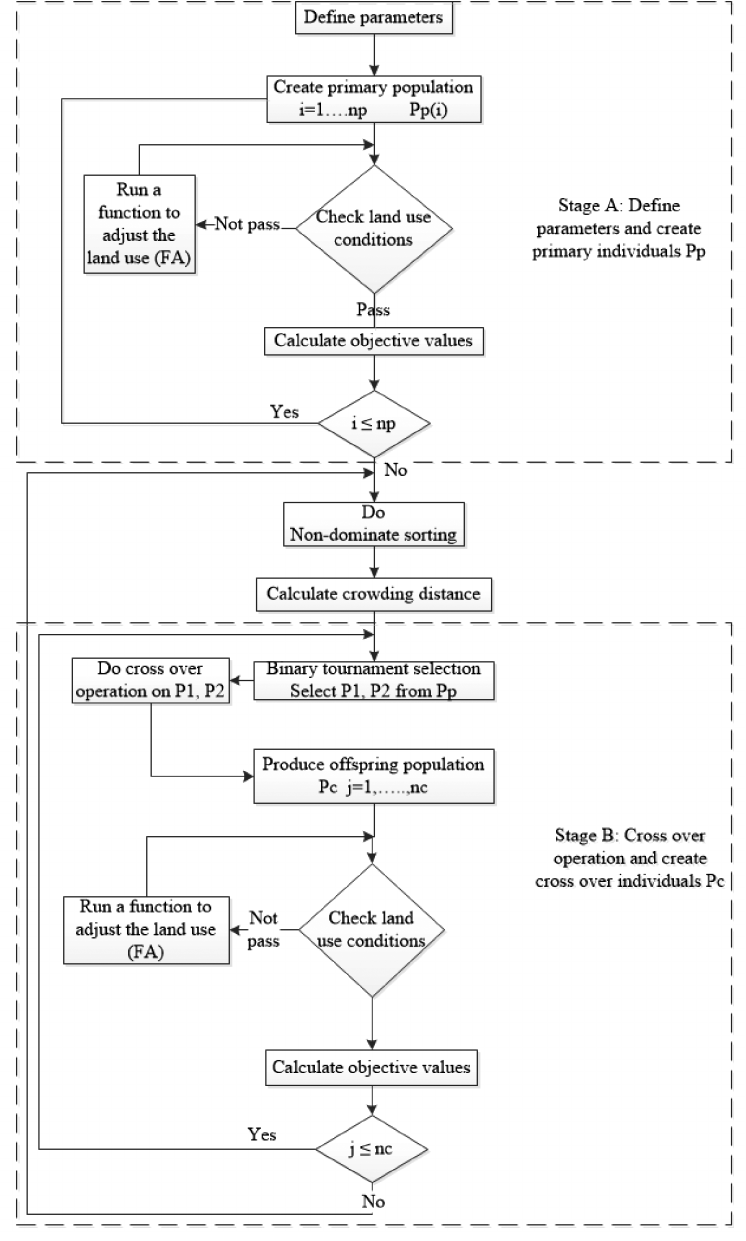
Figure 5. Flow chart showing the NGSA II algorithm implemented in this